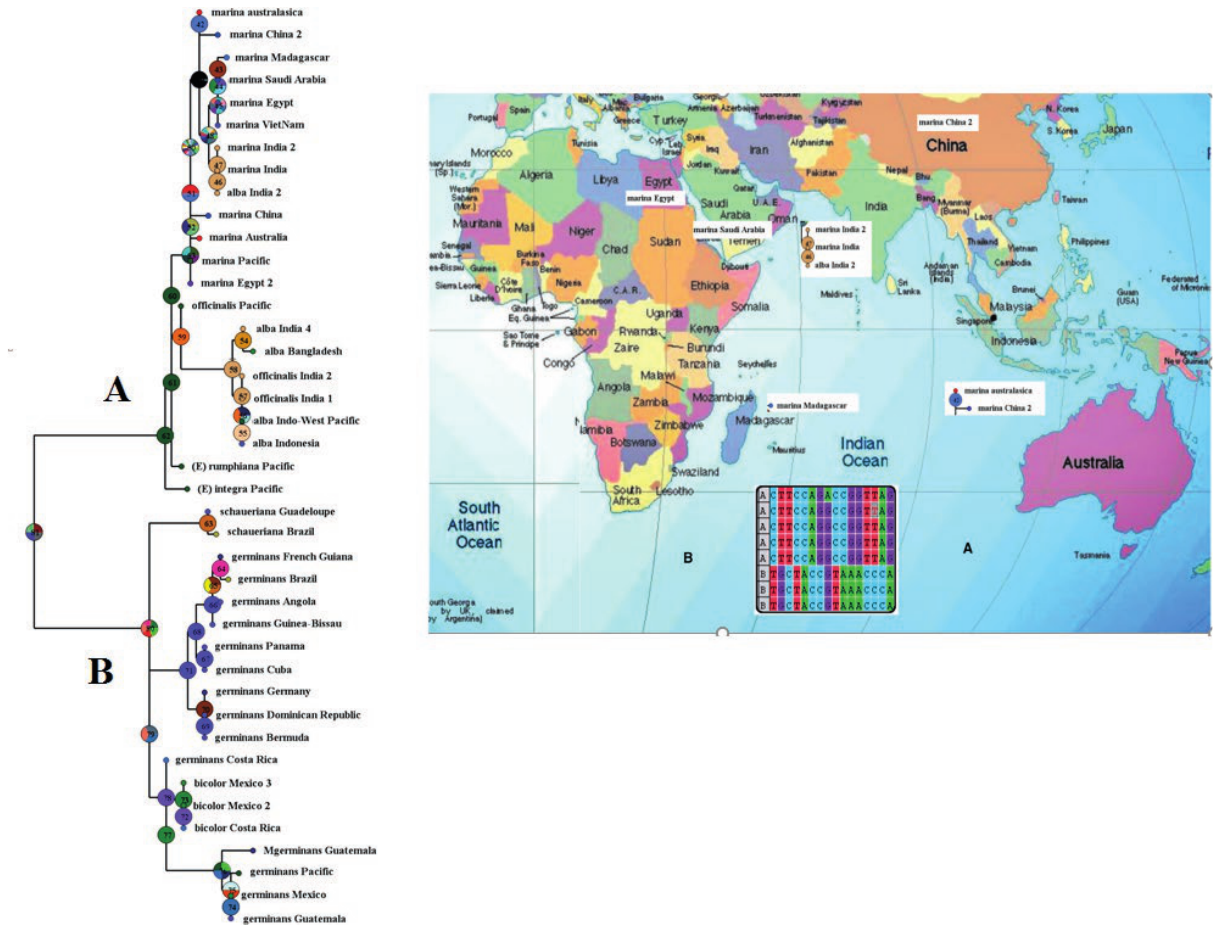
Figure 16. Biogeographical distribution of Avicennia marina populations based on ITS